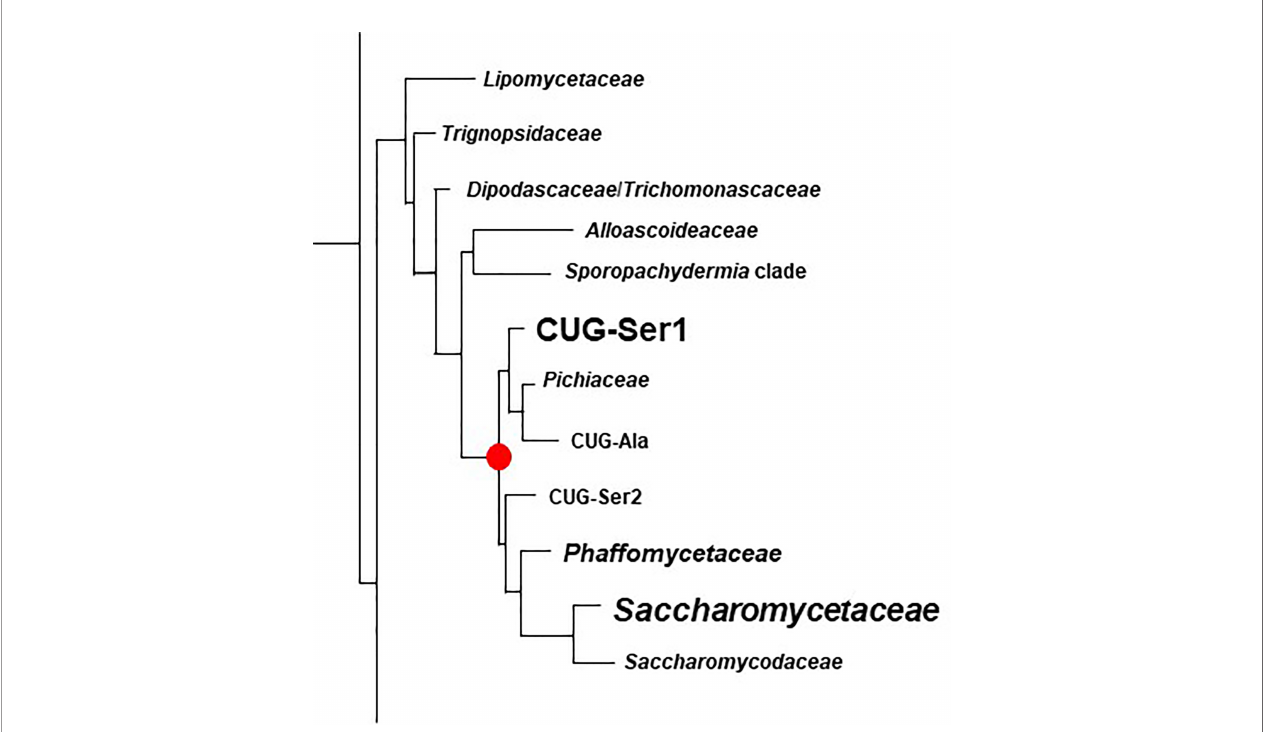
FIGURE 6 | Phylogenetic tree of Families in the Order Saccharomycetales. The tree was traced from the data of Li et al. (2021) to highlight the region of interest for the current study. Family names were those used by Li et al. (2021). Table 4 placed these names into the context of Family designations used on the NCBI Taxonomy Database (Schoch et al., 2020). The red dot denotes the common ancestor of the CUG-Ser1 clade and Saccharomycetaceae , the two groups in which ALS genes were most common (indicated by larger font). ALS genes were also detected in the Phaffomycetaceae